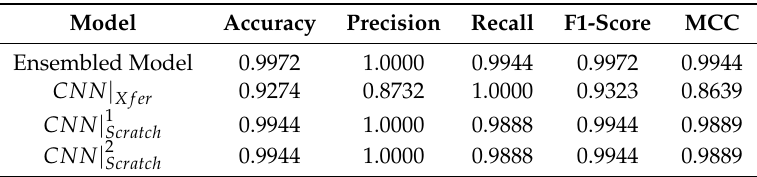
Table 4. Performance summary of the final ensemble model and the individual modules on the test dataset.